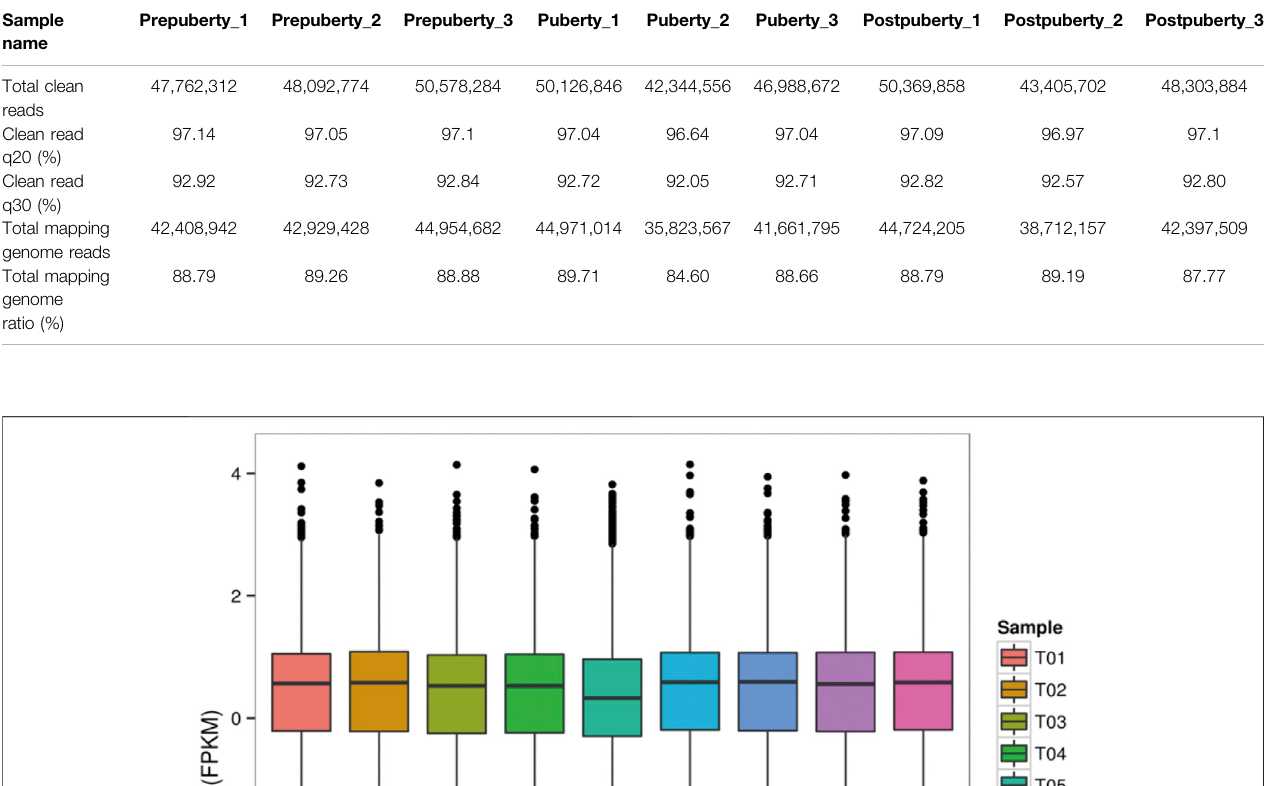
Frontiers in Genetics |